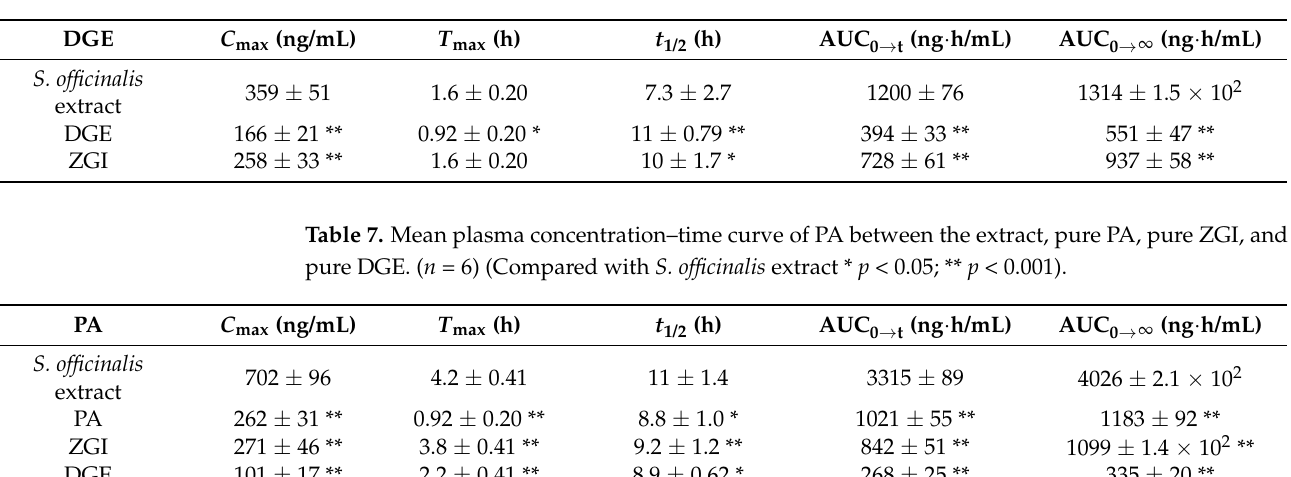
Table 6. Mean plasma concentration–time curve of DGE between the S. officinalis extract, pure DGE, and pure ZGI ( n = 6) (Compared with S. officinalis extract * p < 0.05; ** p < 0.001).